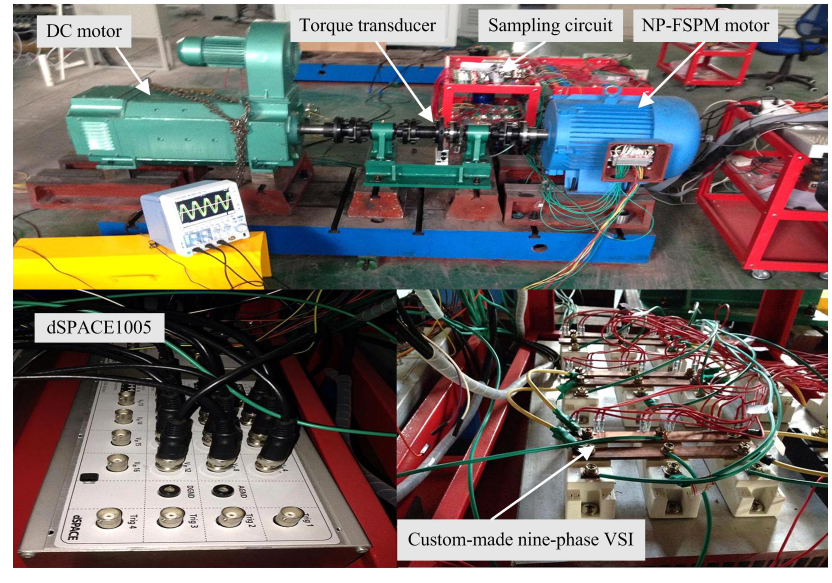
Figure 12. Experiment setup.